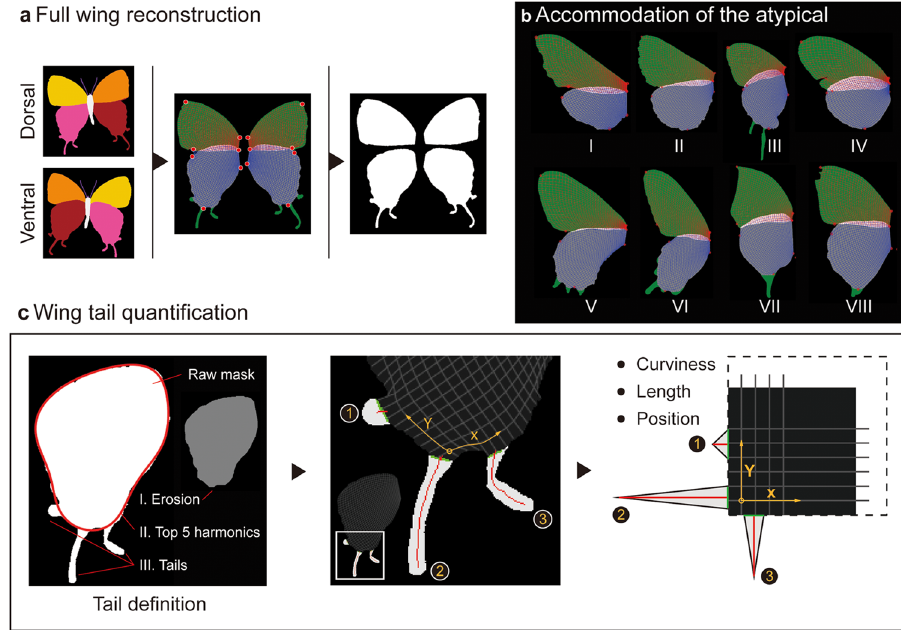
Fig. 4 Diagram illustrating the full wing reconstruction, universal wing grids, and tail quanti fi cation. a Full wing shape can be virtually reconstructed according to dorsal and ventral segmentation. a , b Wing grids can then be generated after c De fi ning the tail regions. In the left panel, the red boundary represents the reconstructed rough shape of a hindwing based on the top fi ve harmonics after being projected into the frequency domain by elliptical Fourier analysis. b Universal wing grids can accommodate distorted or broken wings (e.g., IV & VIII). I. Smerinthus cerisyi (Sphingidae); II. Catocala connubialis (Erebidae); III. Evenus coronata (Lycaenidae); IV. Heliconius melpomene (Nymphalidae); V. Allancastria cerisyi (Papilionidae); VI. Atrophaneura hector (Papilionidae); VII. Kallima inachus (Nymphalidae); VIII. Corades medeba